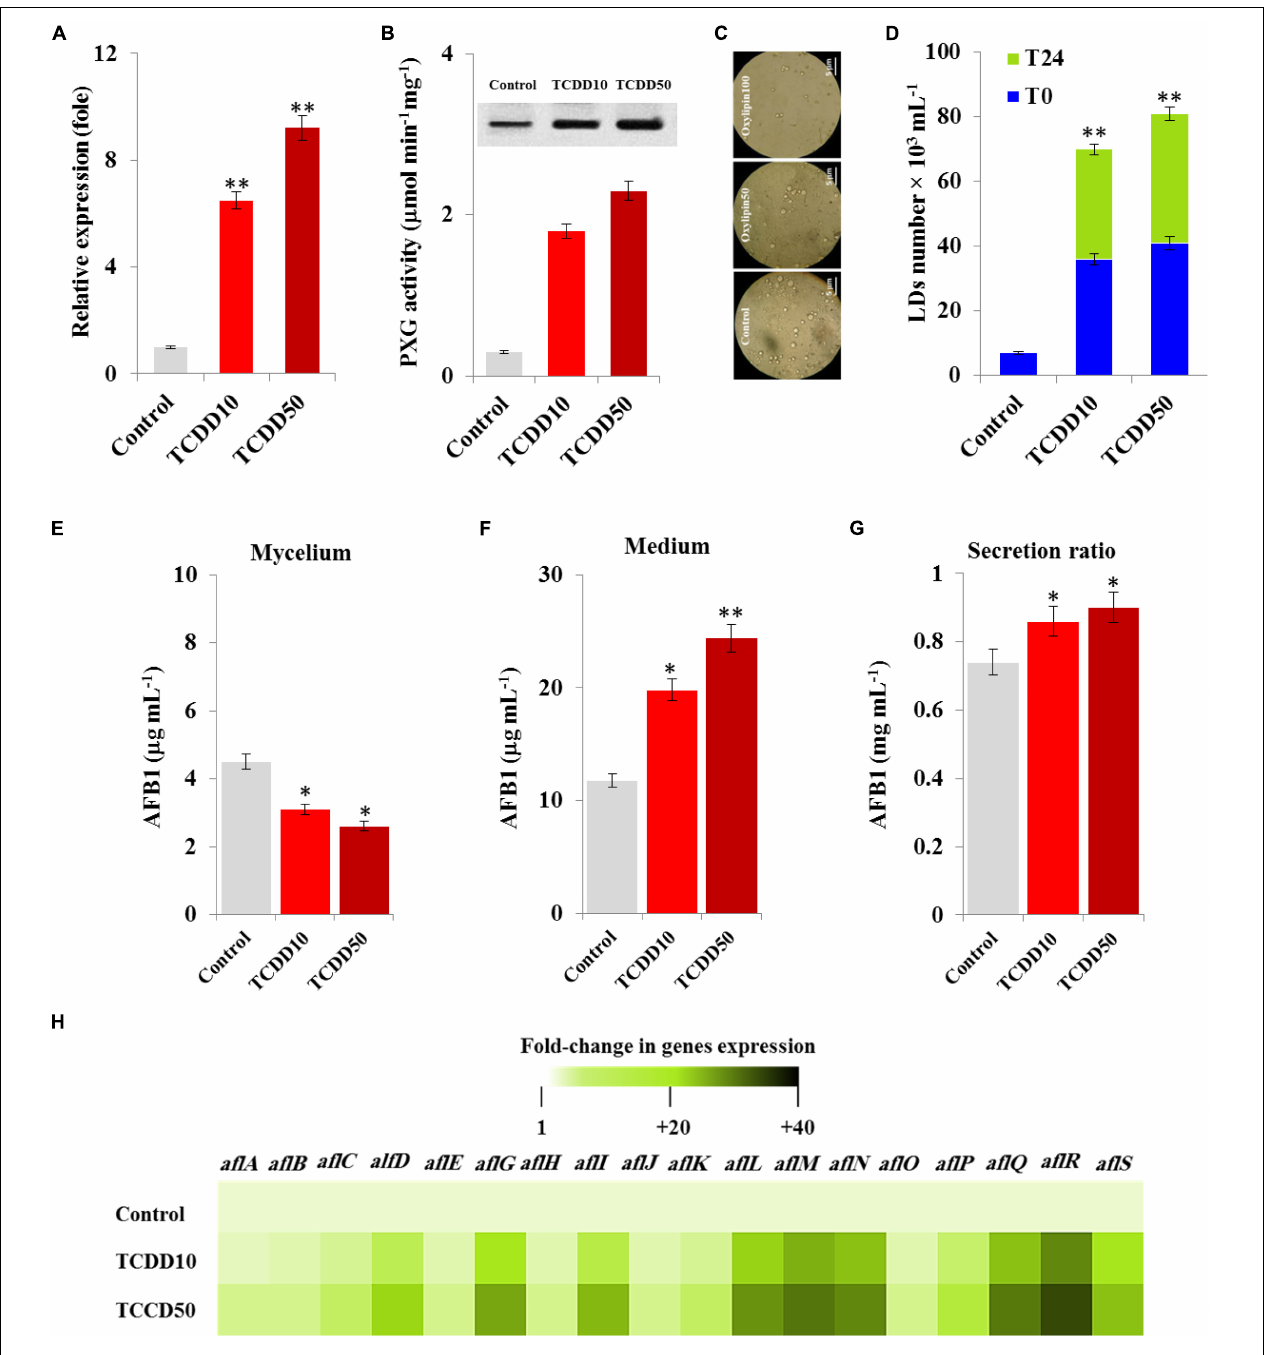
FIGURE 3 | The TCDD induces the functional expression of AfPXG, the accumulation of LDs and the production of AfB1. (A) Transcripts level of AfPXG gene, evaluated by RT-qPCR, in the fungal tissues exposed or non-exposed to TCDD. (B) The peroxygenase activity of AfPXG, estimated by the hydroxylation of aniline at 310 nm. (C) Micrographs of LDs isolated from fungal tissues exposed or not exposed to TCDD. Samples were examined under a LEICA MPS60 light microscope and the images were taken at a magnification of 40 × immediately after preparation. Bar represents 5 µ m. (D) LD number was estimated using a hemocytometer. (E,F) Measurement of AFB1 in the fungal mycelium and in the culture medium of A. flavus exposed or not exposed to TCDD. (G) Secretion ratio of AFB1 by fungi exposed or not exposed to TCDD (calculated as the ratio of AFB1 in the medium to AFB1 in medium plus mycelia in a 100 mL culture). (H) Relative quantification RQ = 2 ( − (cid:49)(cid:49) CT ) of AF-biosynthesis gene transcripts upon the exposure to TCDD compared to control. The color scale (white-green-black) indicates relative changes of transcripts of 1, +20, and +40-fold, respectively. For each gene, the expression level in the control was defined as 1, and the corresponding increase in gene transcript under treatments was calculated. All measurements were done in triplicate and the presented data are means ± SD ( n = 3). The differences between control and treatments were significant when analyzed by t -test ( ∗ P < 0.05; ∗∗ P < 0.01).